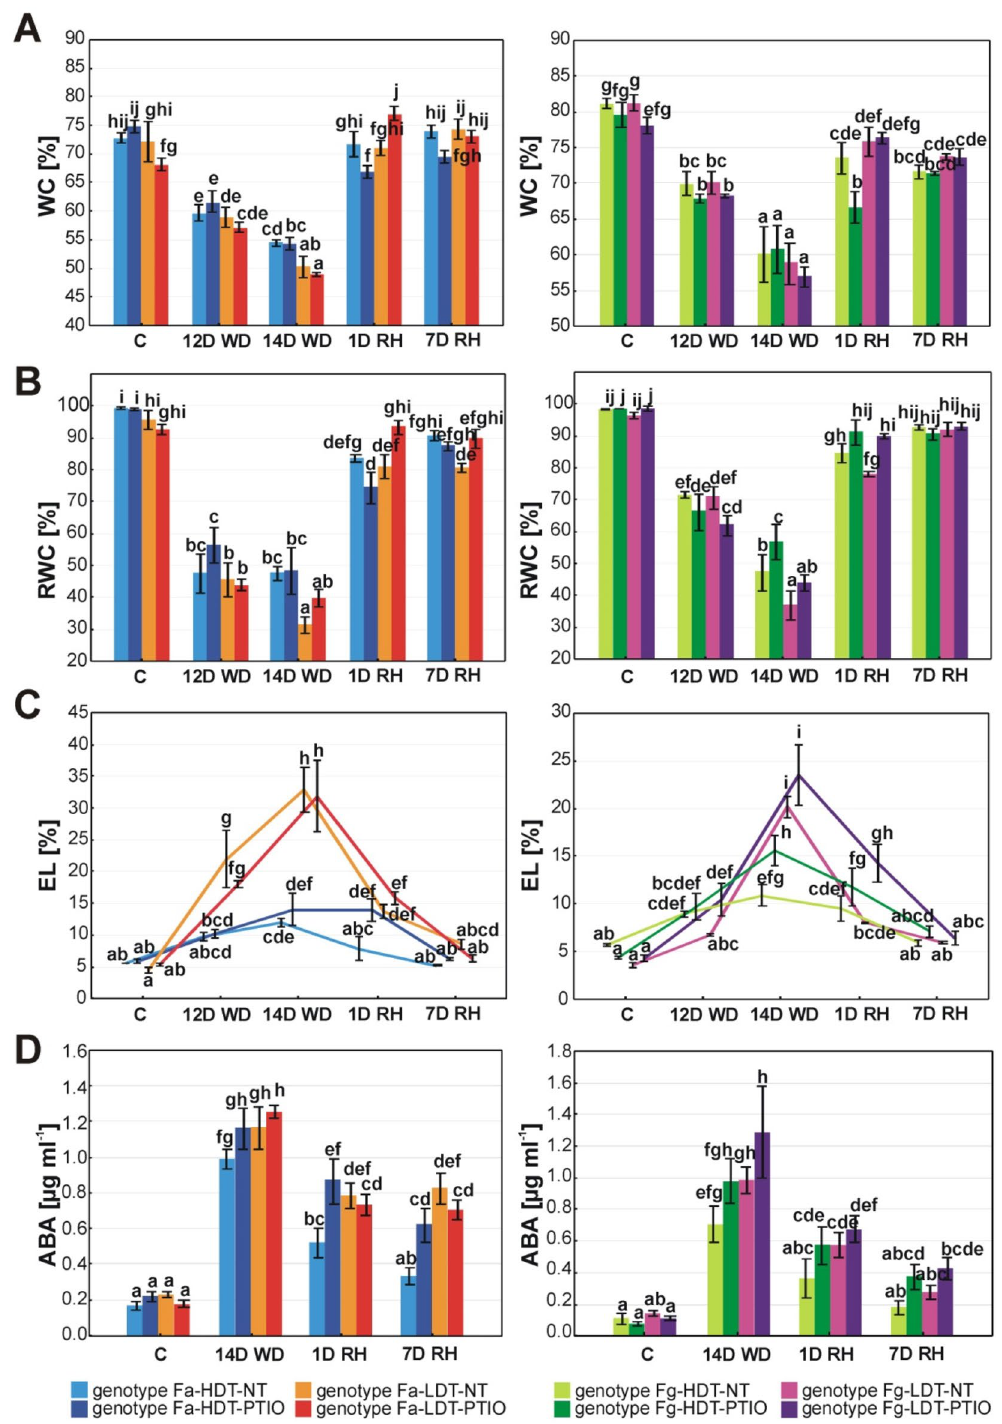
Figure 2. Changes in the leaf physiological parameters: water content (WC) ( A ), relative water content (RWC) ( B ), electrolyte leakage (EL) ( C ) and accumulation of abscisic acid (ABA) ( D ) in the analyzed high drought tolerant (HDT) and low drought tolerant (LDT) Festuca arundinacea (Fa) and F. glaucescens (Fg) genotypes non-treated with PTIO (NT) and treated with 200 µM PTIO (PTIO) at control conditions (C), on the 12th day of water deficit (12D WD), 14th day of water deficit (14D WD), 1st day of re-watering (1D RH) and 7th day of re-watering (7D RH). Error bars represent the standard errors. Homogeneous groups are denoted by the same letter according to Fisher-LSD test (p = 0.05). PTIO